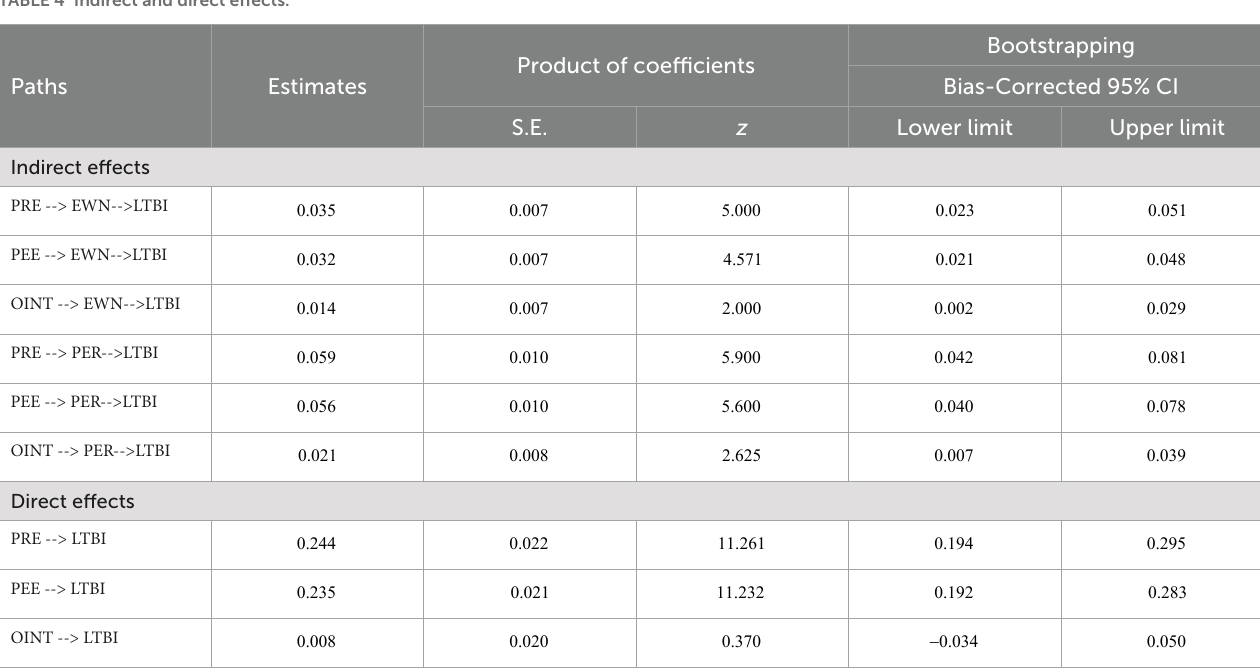
TABLE 4 Indirect and direct